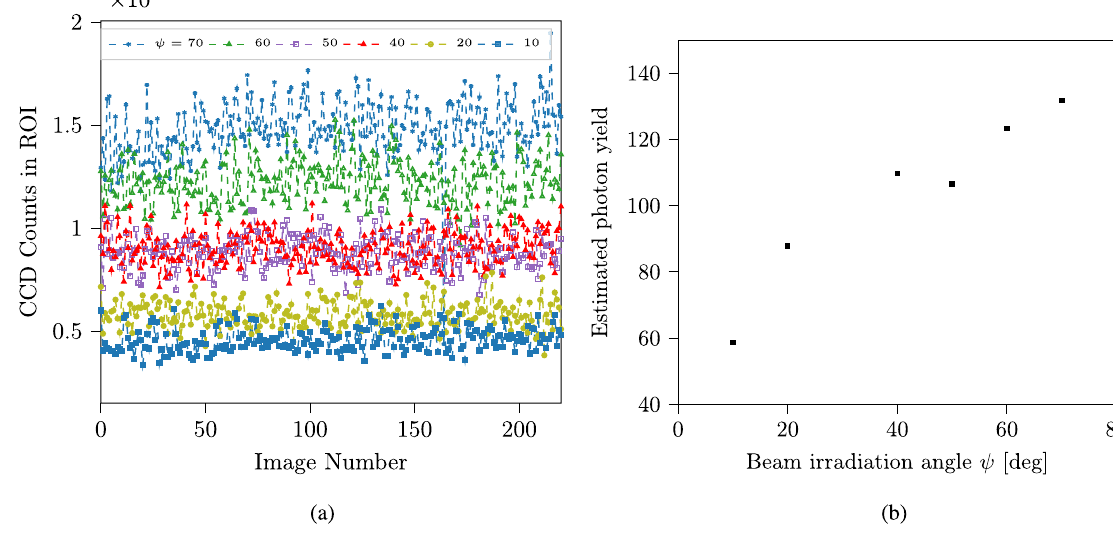
FIG. 18. (a) CCD counts from aluminum target for various irradiation angles when the polarizer angle is set to 0°. (b) The number of average photons reaching the detector as a function of irradiation